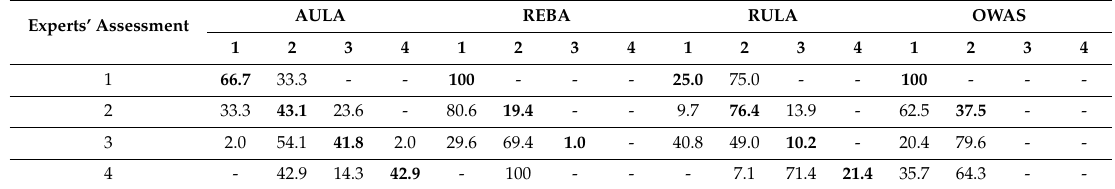
Table 3. Hit rates of ergonomic risk assessment tools and expert assessments [unit: %].